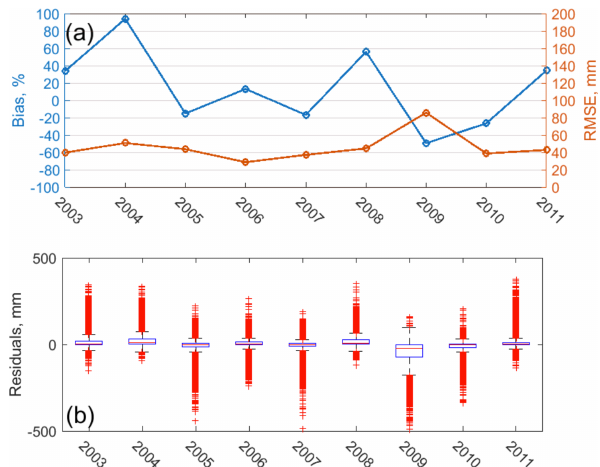
Figure 8. (a) Bagged trees bias and RMSE; (b) residuals (machine learning prediction – reconstructed SWE) by year with red line as the median, boxes encompassing the 25th ( p 25 ) and 75th ( p 75 ) per- centiles, whiskers showing non-outlier ranges, and crosses indicat- ing outliers, defined as points greater/less than p 75 ± w(p 75 − p 25 ) , with w = 15.